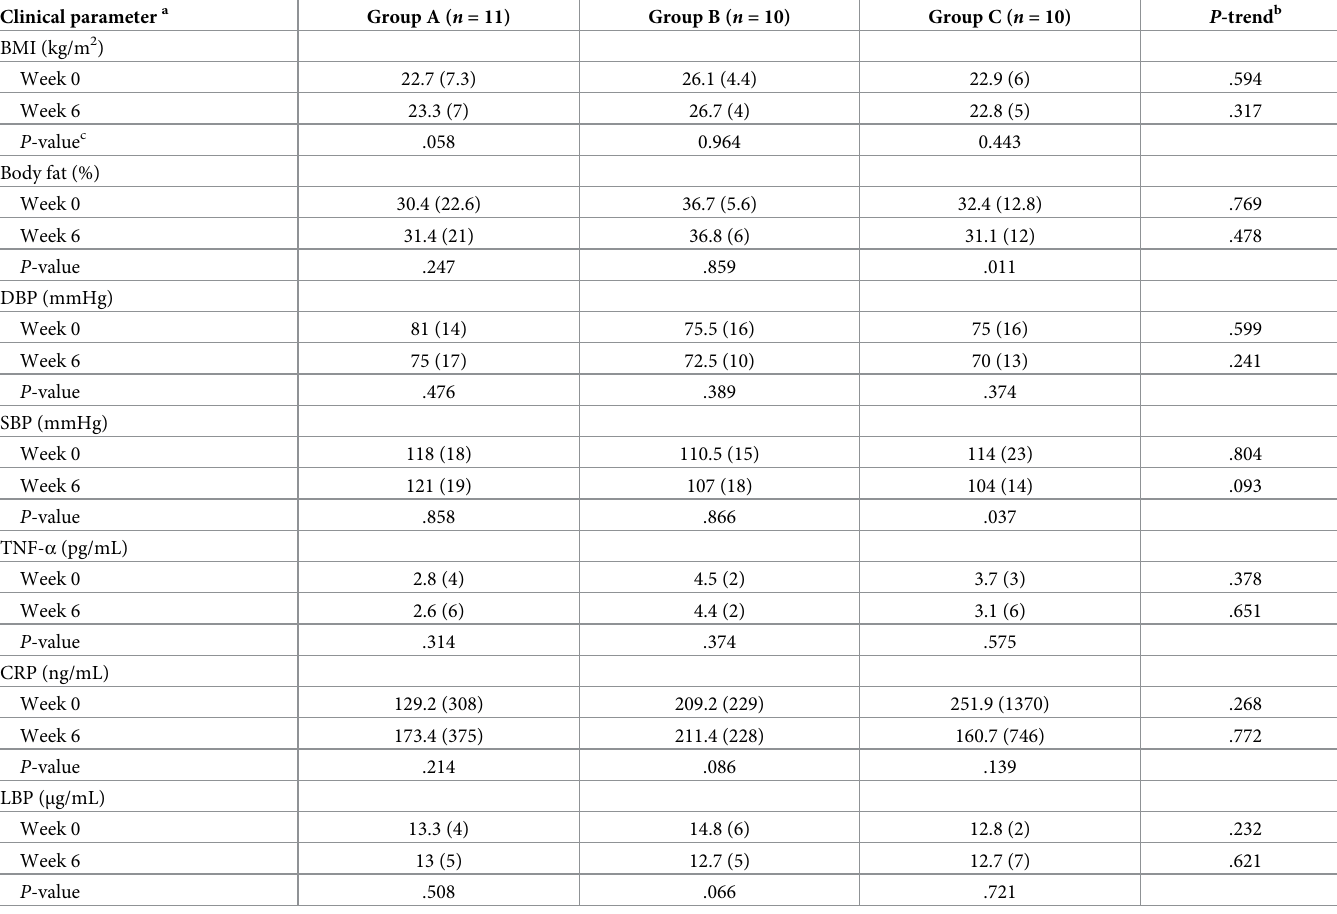
Table 3. Levels of inflammatory markers and other clinical parameters before and after the six-week intervention.